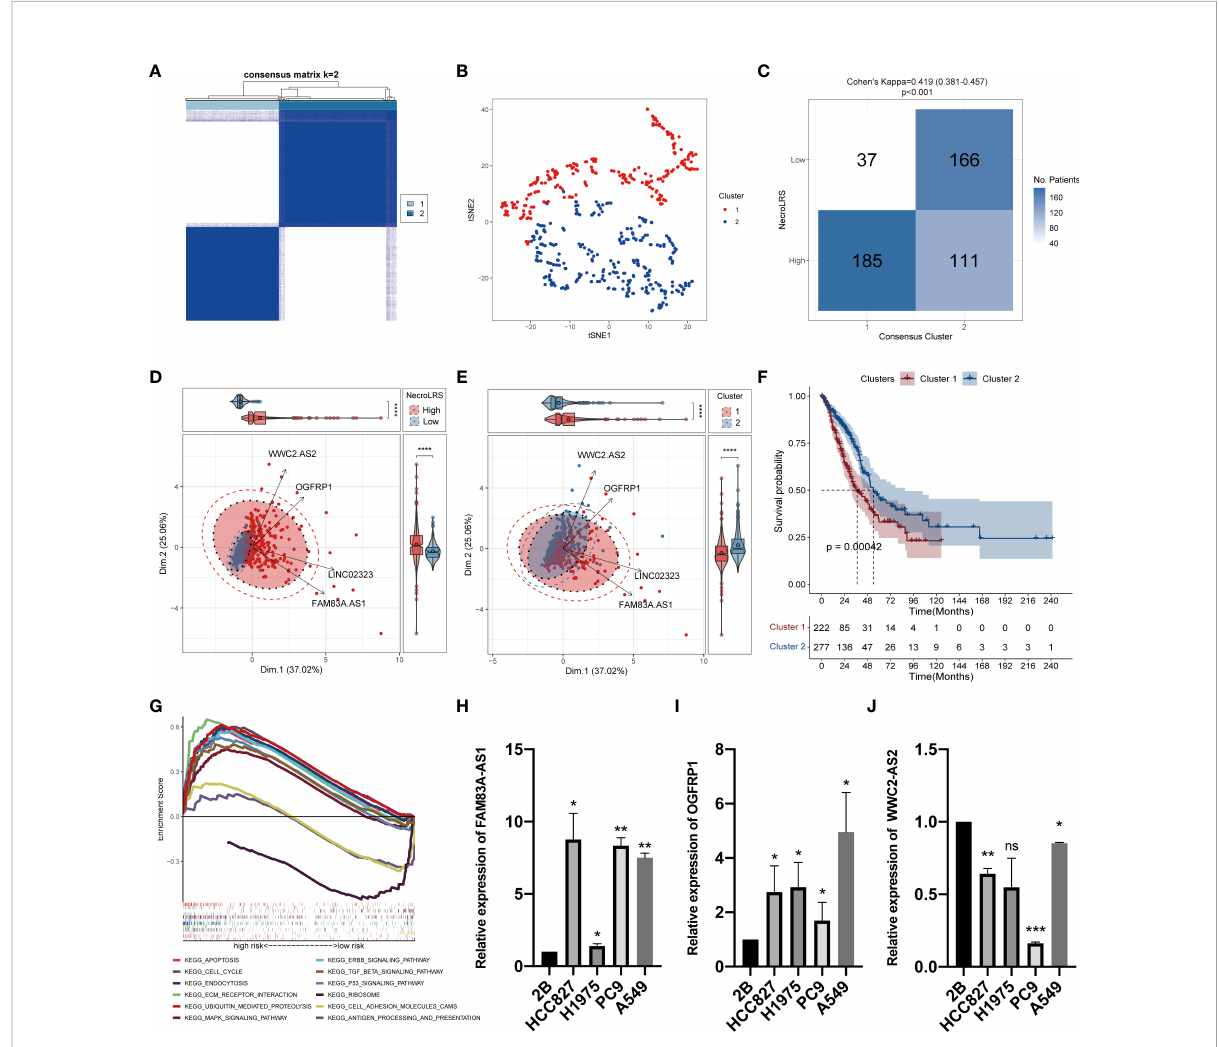
FIGURE 4 In vitro expression and unsupervised clustering based on NecroLRS-related lncRNAs. (A) Consensus matrix derived from